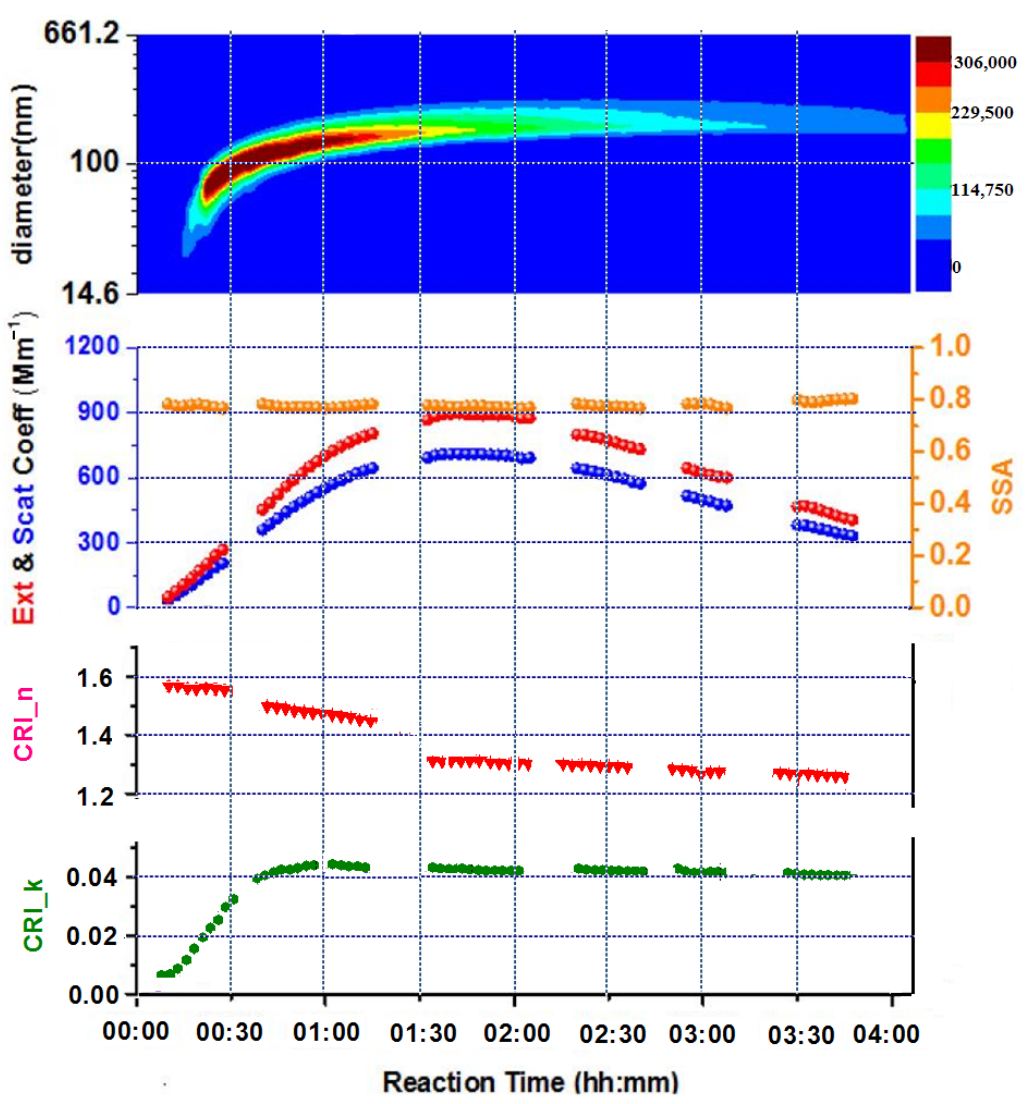
Figure 4. The particle number concentration, mean diameter, extinction and scattering coefficients, single-scattering albedo (SSA) and CRI of SOA formed in presence of 300 μg/m 3 (NH 4 ) 2 SO 4 seed as a function of reaction time.